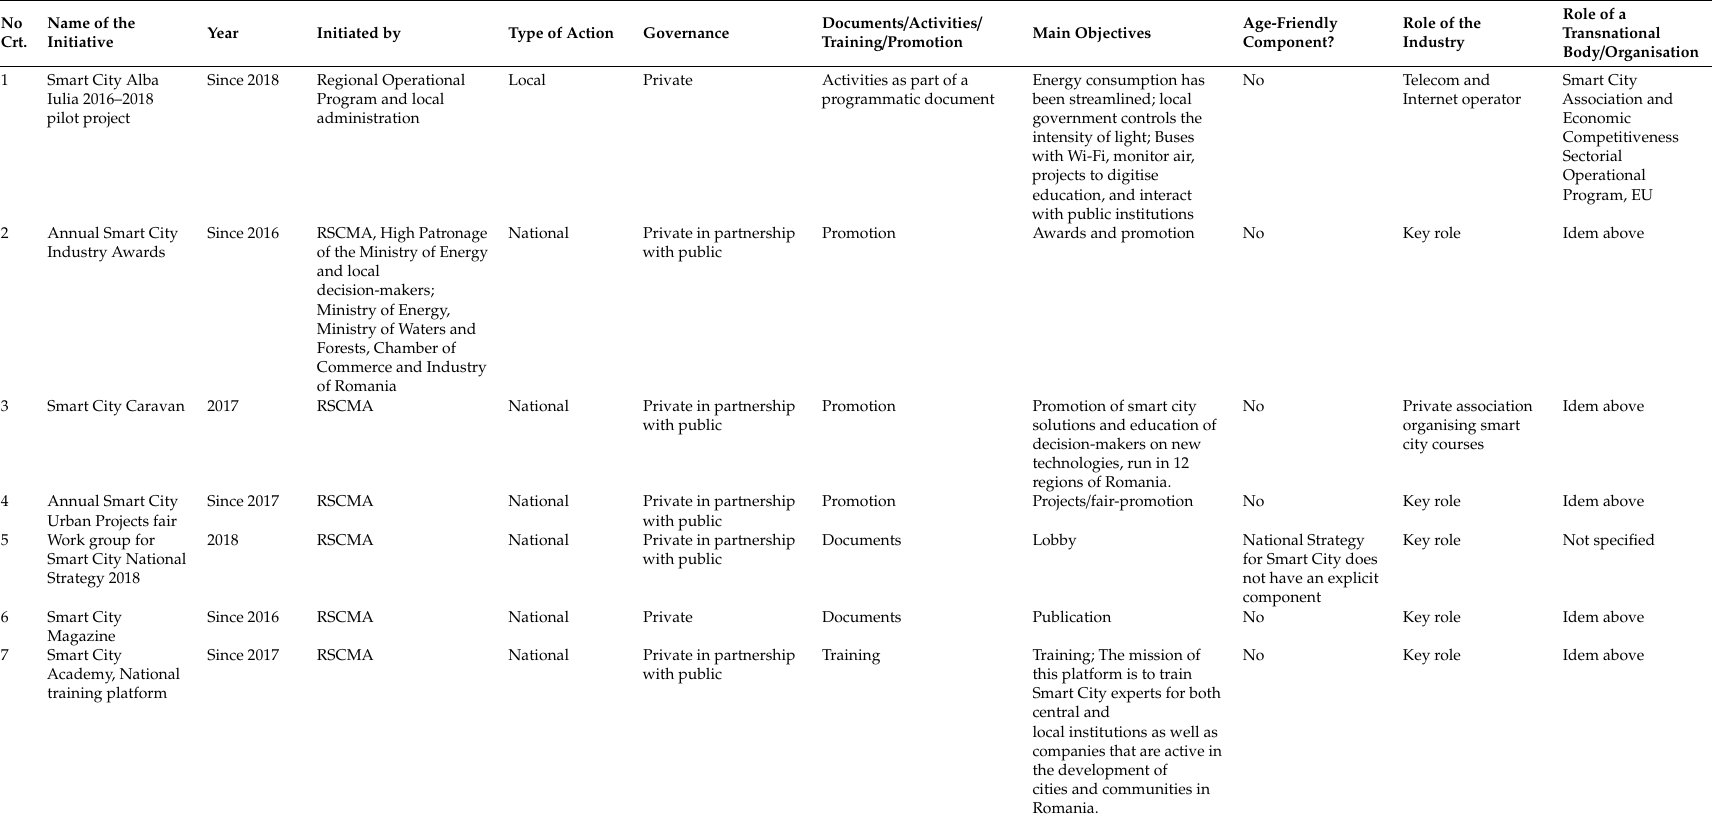
Table A1. The corpus of analysis and the results of the coding